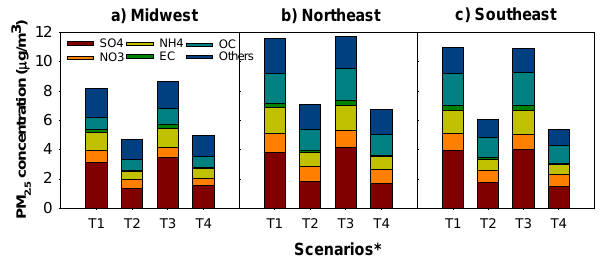
Figure 8. The cumulative probability function of MDA8 ozone for GEOS-Chem and CMAQ: (a) Midwest for GEOS-Chem, (b) Northeast for GEOS-Chem, (c) Southeast for GEOS-Chem, (d) Midwest for CMAQ, (e) Northeast for CMAQ, and (f) Southeast for CMAQ. 5